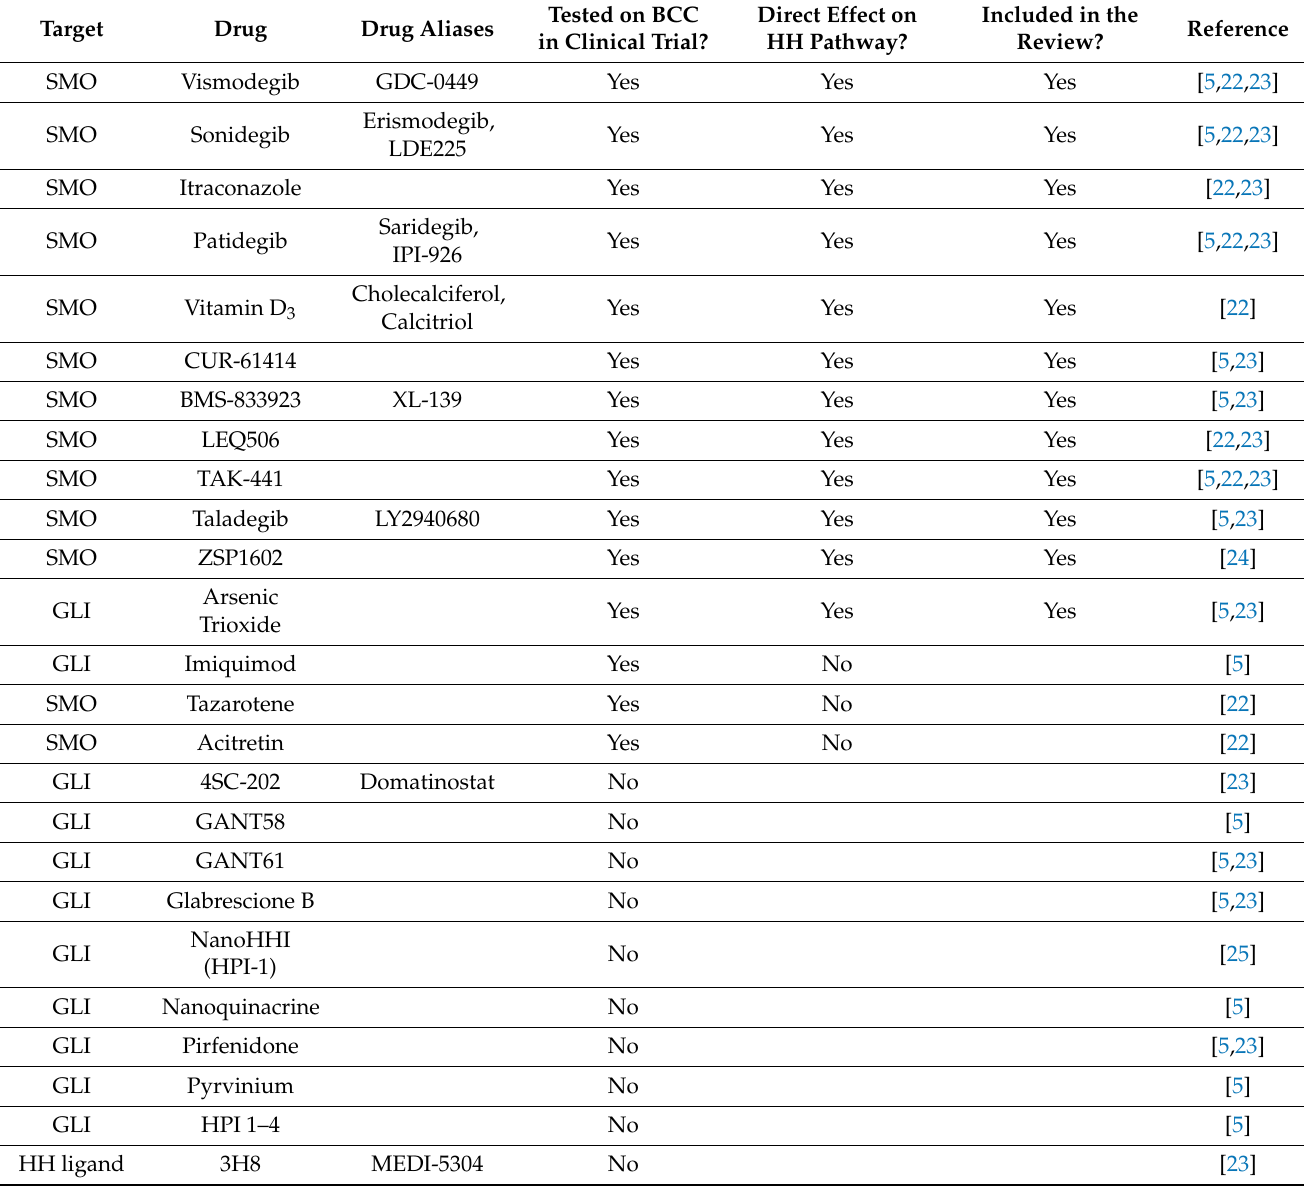
Table 1. Overview of different hedgehog inhibitors (HHis) and their molecular target. We selected HHis by first determining whether the HHis have been tested on BCCs in a clinical trial followed by investigation of whether the HHi has a direct effect on the HH pathway. Empty cells indicate that the drug was excluded in previous steps. Tested on BCC Direct Effect on Included in in Clinical Trial? HH Pathway?